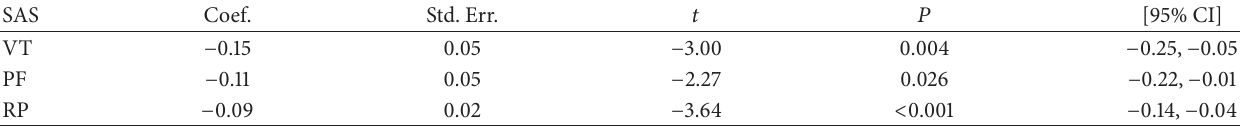
Table 4: Stepwise regression analyses of medical and psychological variables and their relationship to SAS in SLE patients. SAS Coef. Std. Err. 𝑡 𝑃 [95% CI] VT − 0.15 0.05 − 3.00 0.004 − 0.25, − 0.05 PF − 0.11 0.05 − 2.27 0.026 − 0.22, − 0.01 RP − 0.09 0.02 − 3.64 < 0.001 − 0.14, −